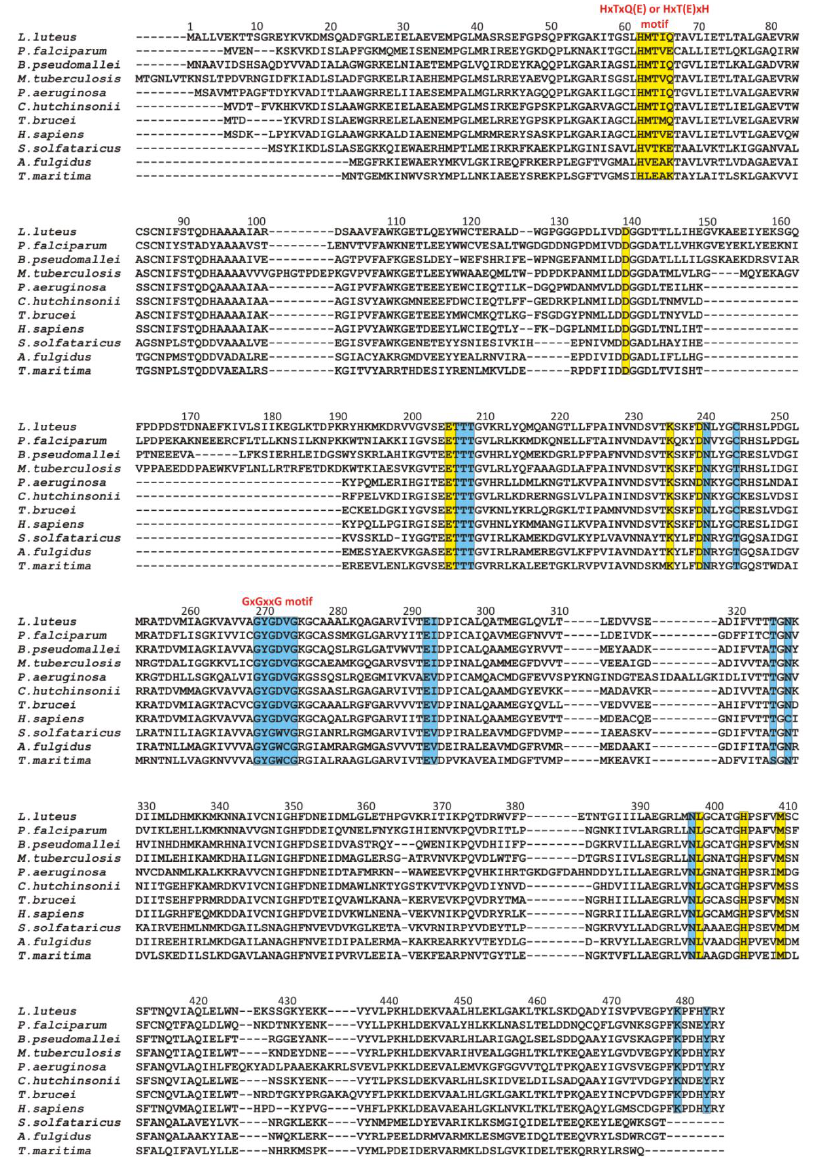
Figure 3. Multiple sequence alignment of selected SAHases. Residues on the yellow background are involved in a ligand binding in the substrate-binding domain, while residues on the blue background interact with the NAD + cofactor molecule in the cofactor-binding domain. Two specific motifs involved in a ligand binding are highlighted. Amino acid residue numbers correspond to those of LlSAHase.The alignment includes the sequences of the following species (UniProt accession code):